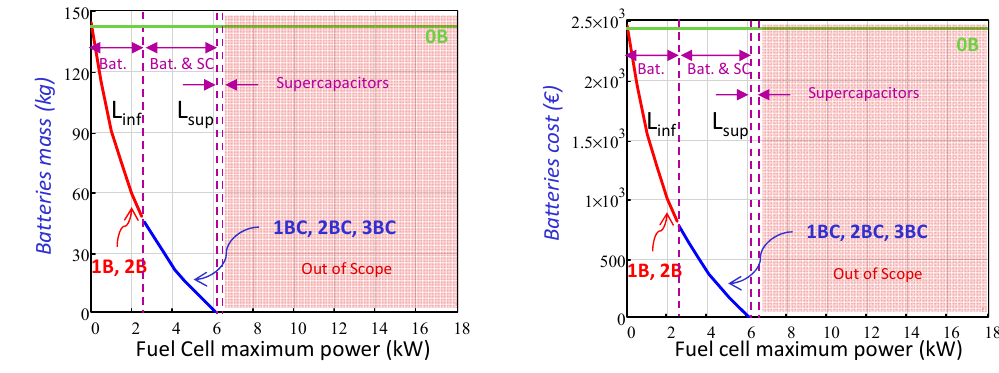
Figure 11. Batteries mass and cost.